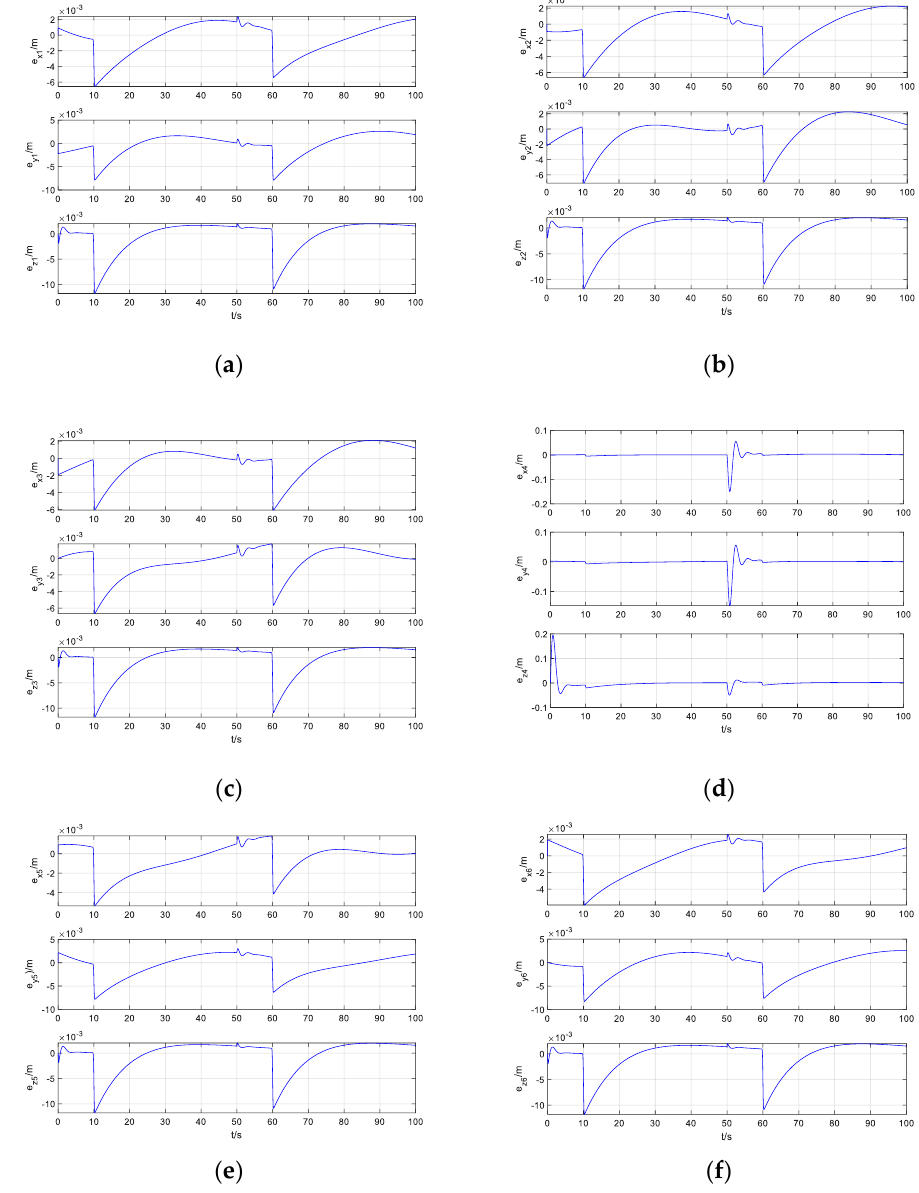
Figure 6. Follower1-Follower6 tracking error: ( a ) Follower1; ( b ) Follower2; ( c ) Follower3; ( d ) Fol- lower4; ( e ) Follower5; ( f )